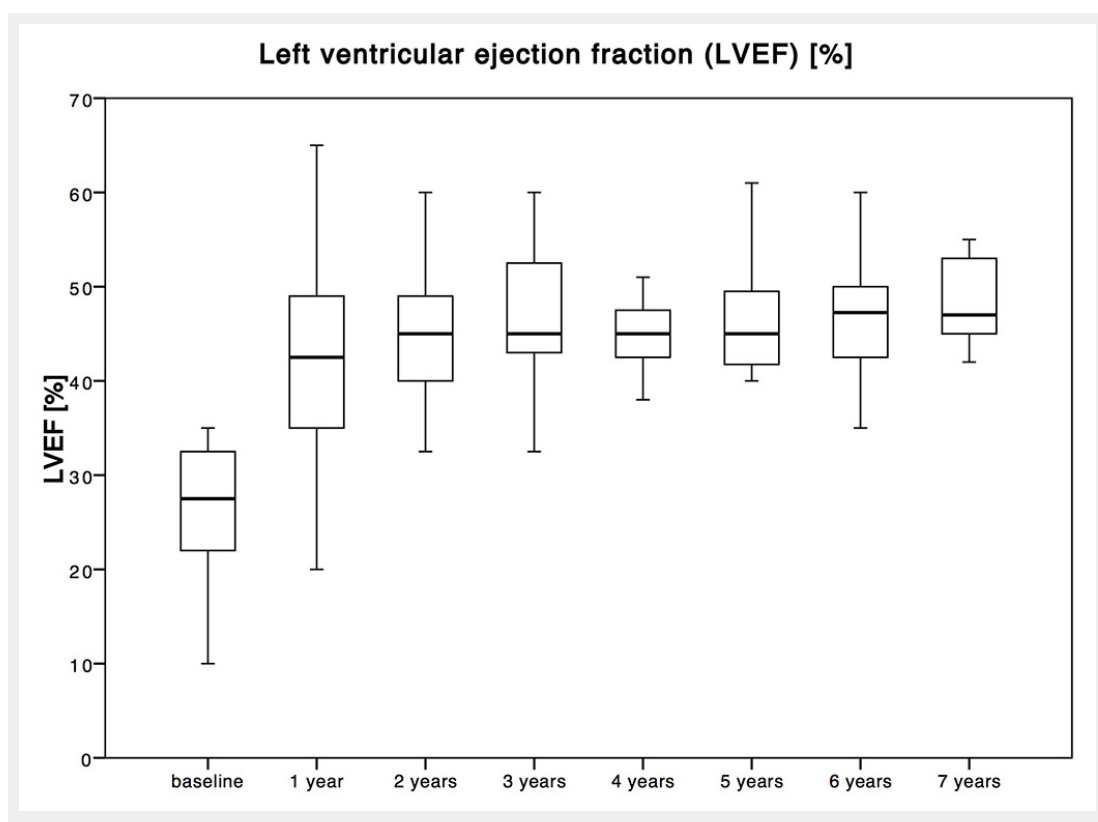
Figure 2 Changes in ejection fraction during long-term follow-up in patients with improvement to >40% (boxes indicate the interquartile range, whiskers 1.5-fold the length of the